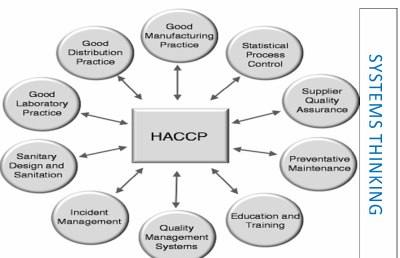
Figure 1. ‘Prerequisite programmes (PRPs) adapted from What is a Management System? Available online: https://images.app.goo.gl/Aqez5sSfpbvjQqmK7 (accessed 20 June